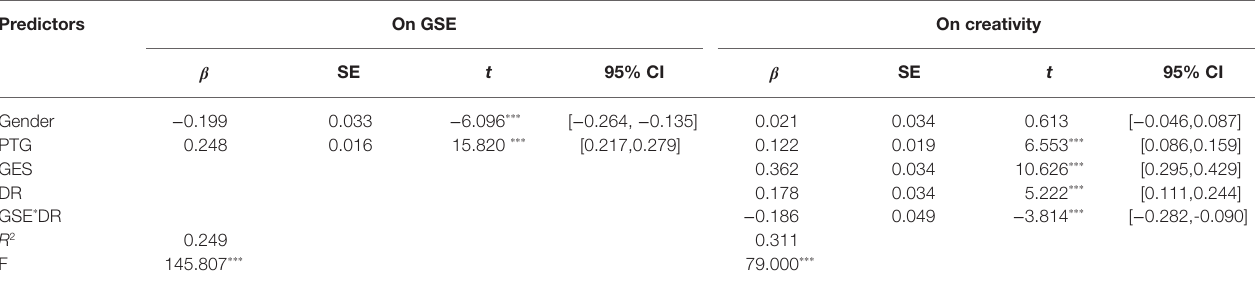
TABLE 4 | Testing the moderated mediating effect of PTG on creativity. Predictors On GSE On creativity